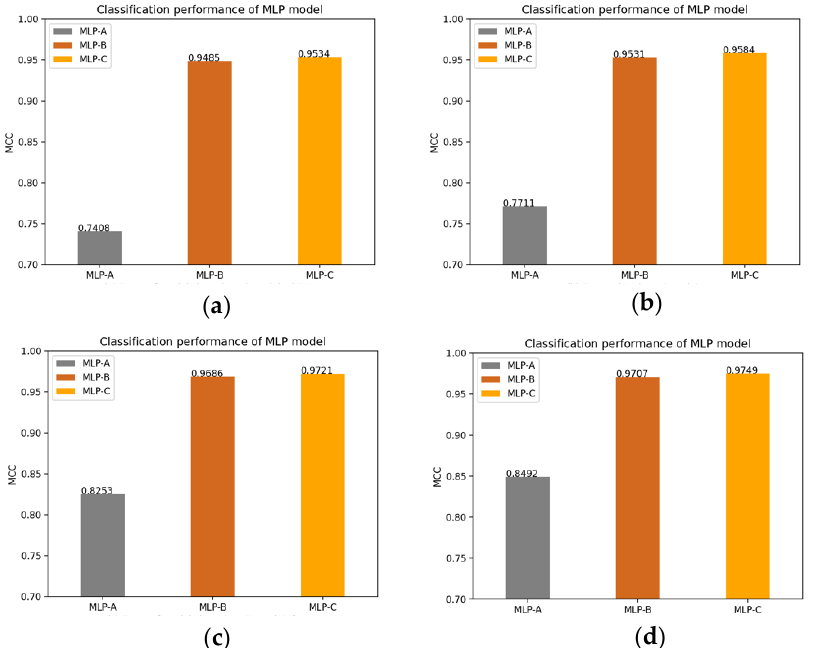
Figure 14. ( a ) Models without attention mechanism; ( b ) Models add self-attention mechanism; ( c ) Models add external-attention mechanism and Softmax; ( d ) Models add external-attention mechanism and double normalization.